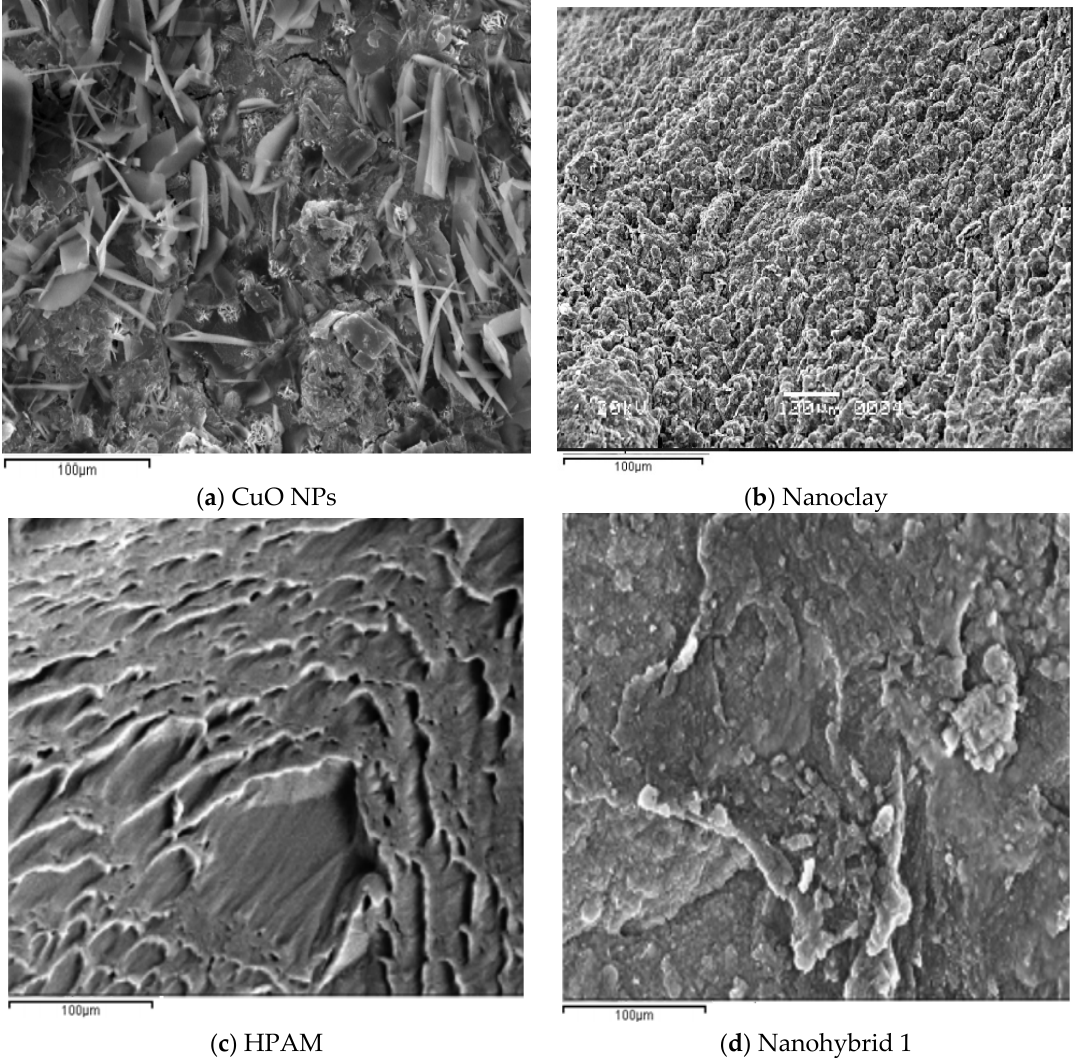
Figure 2. SEM images of ( a ) CuO NPs (nanoparticles); ( b ) nanoclay; ( c ) dried HPAM (Partially hydrolyzed polyacrylamide) solution; and ( d ) dried nanohybrid 1.